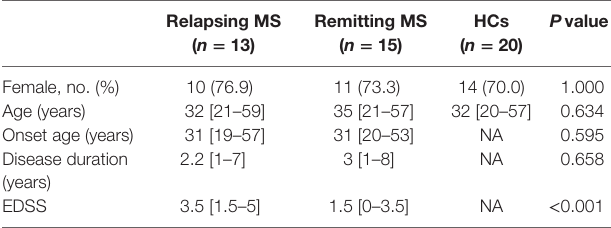
TaBle 1 | Demographic and clinical characteristics of relapsing-remitting MS patients and